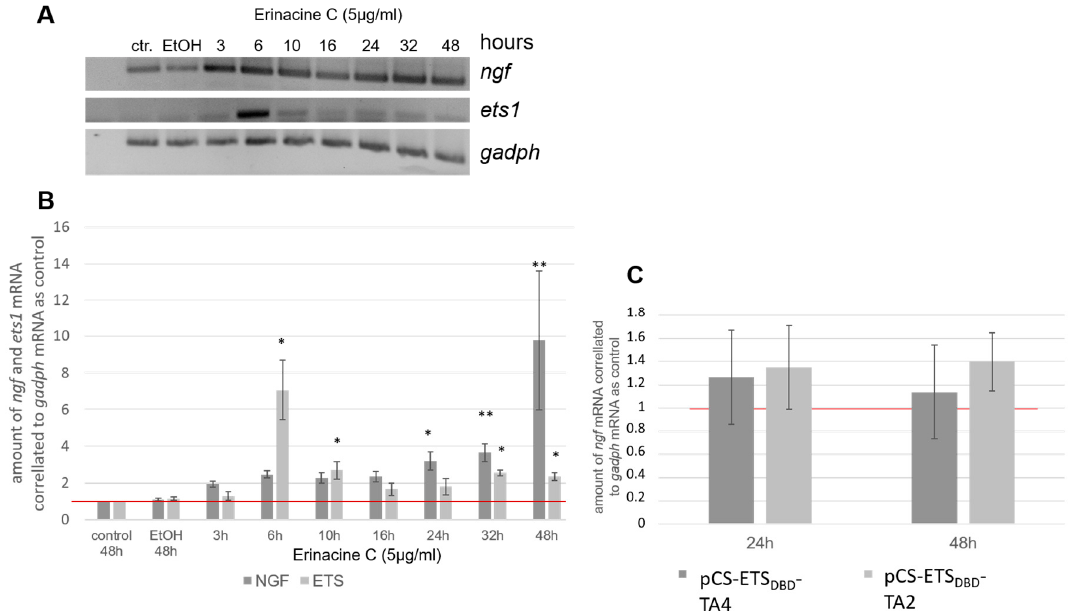
Figure 6. ETS-activity alone may not induce NGF expression in astrocytic 1321N1 cells. ( A ) Semiquantitative RT-PCR against ets1 , ngf , and gapdh (control) mRNA expression in erinacine C incubated 1321N1 cells after various timepoints of compound incubation. ( B ) Average ratios of ets1 or ngf compared to gapdh mRNA ( n = 3 independent RT-PCRs) were displayed against different erinacine C incubation periods. As controls untreated (ctr.) or EtOH-treated 1321N1 cells were used. ( C ) ngf/gapdh mRNA ratios after transfection of astrocytic 1321N1 cells with the constitutively active transcriptional activators ETS1 DBD -TA4 or ETS1 DBD -TA2 followed by 24 and 48 h of incubation, respectively. ets1 / gapdh mRNA ratio in untreated cells incubated for 48 h with serum-reduced medium was set as one indicated by a red line in B and C (three independent cultures). * p < 0.05, ** p < 0.01.